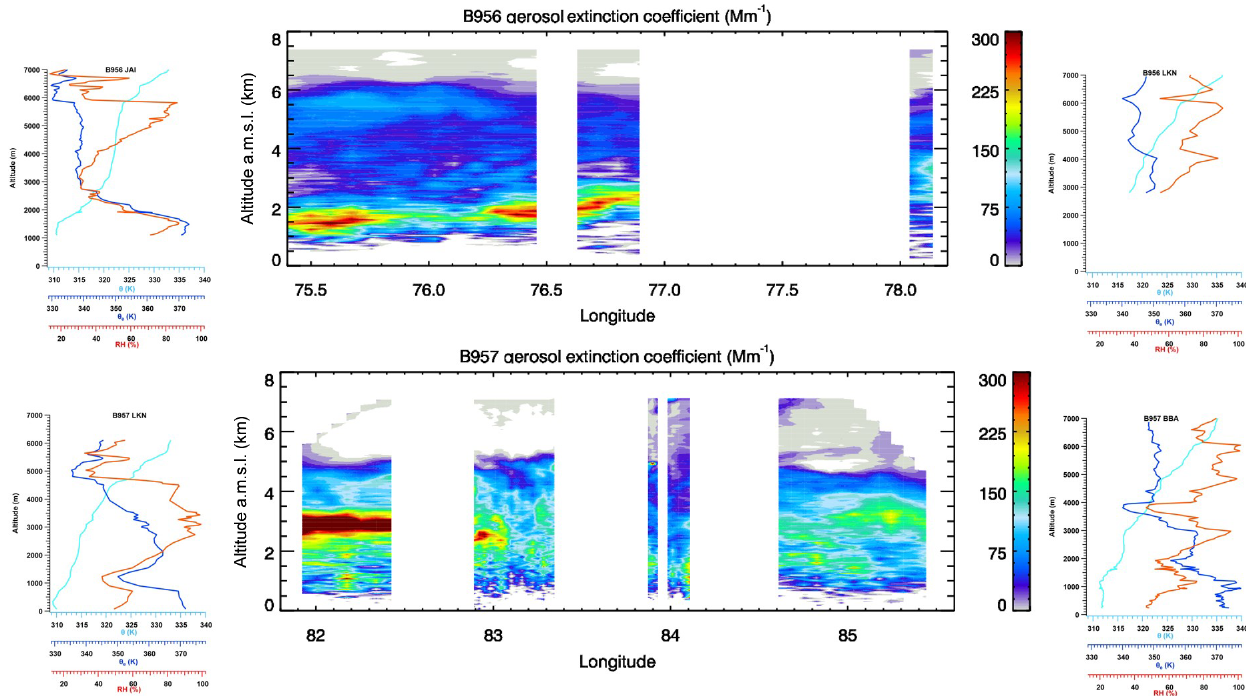
Figure 3. Aerosol extinction coefficient estimated from backscatter lidar observations, for the indicated flights of B956 (11 June) and B957 (12 June) in the pre-monsoon season along the longitudinal scale 75 to 90 ◦ E. Gaps indicate missing data, due to either rejection of whole profiles or rejection of the portion of profiles affected by clouds. The thermodynamic plots of potential temperature ( θ ), equivalent potential temperature ( θ e ) and relative humidity on the right and left of the lidar profiles are for the location indicated by title of the plot (JAI = Jaipur (26.91 ◦ N, 75.79 ◦ E), LKN = Lucknow (26.85 ◦ N, 80.95 ◦ E), BBA = Bhubaneswar (20.30 ◦ N, 25.83 ◦